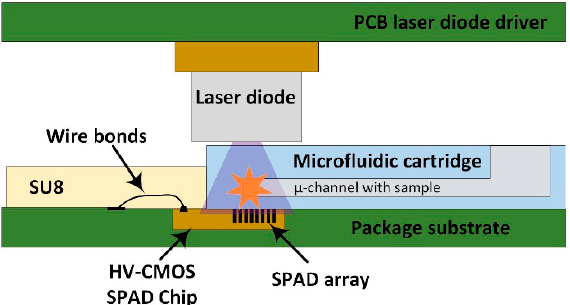
Figure 1. Cross-sectional sketch of the stack up of the system. The sample is introduced in one of the microchannels of the microfluidic cartridge, which is directly positioned on top of the SPAD array, where the wire bonds encapsulation with SU-8 prevents it from entering further.